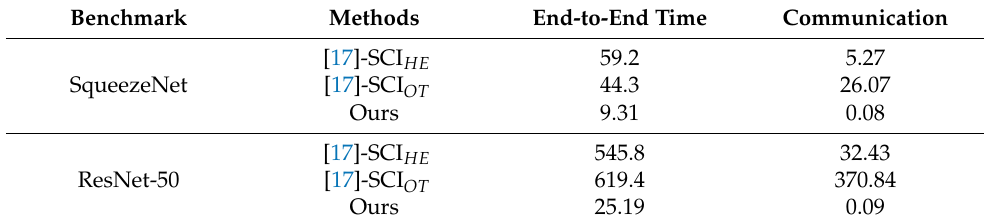
Table 4. Performance comparison with CrypTFlow2 [17] for End-to-End time and communication. Time is measured in seconds and communication in GB. Benchmark Methods End-to-End Time